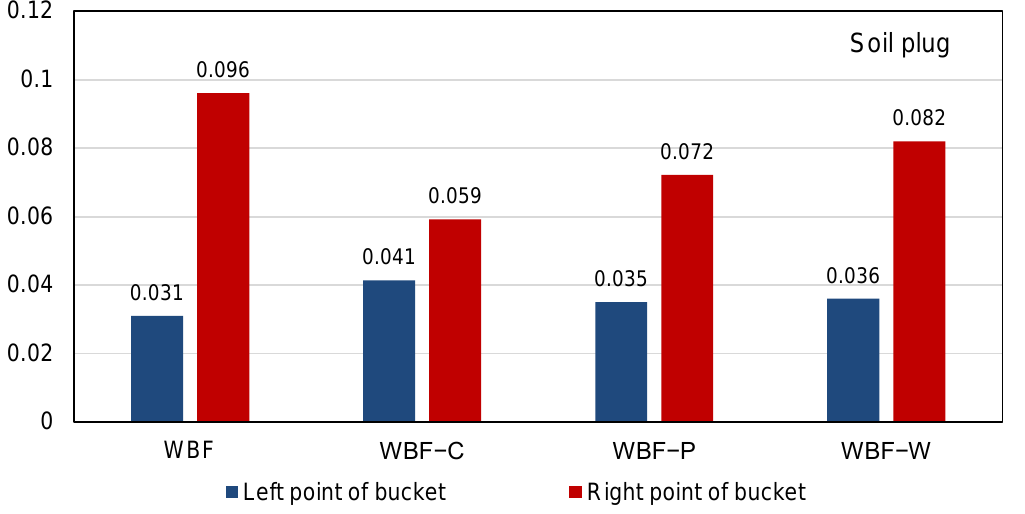
Figure 17. The maximum settlement of the wide bucket foundation (WBF) with different reinforce- ment types in 50% relative density inclined seabeds.